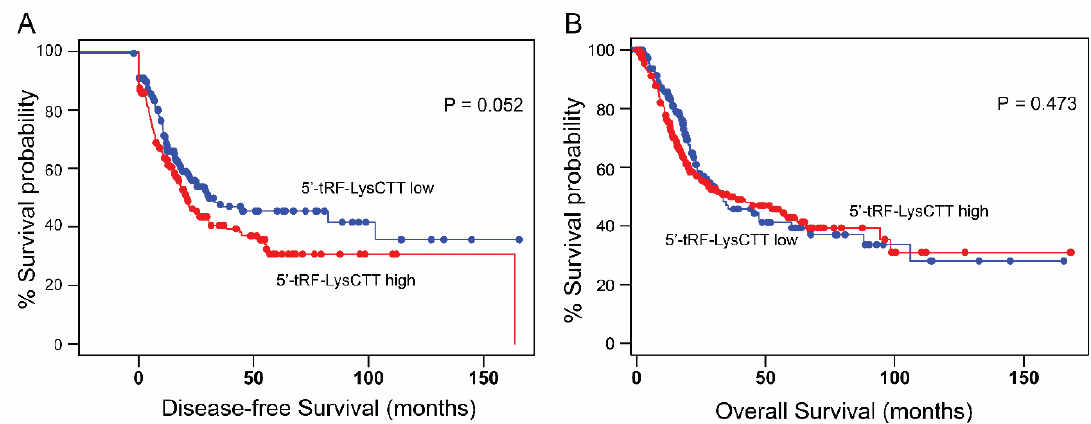
Figure 6. Survival analysis of TCGA-BLCA validation cohort. ( A , B ) Kaplan–Meier survival curves for the disease-free survival (DFS; ( A )) and overall survival (OS; ( B )) of the TCGA-BLCA validation cohort according to 5 ′ -tRF-LysCTT levels. The analysis performed via the OncotRF database. Red line: 5’-tRF-LysCTT high levels; blue line: 5’-tRF-LysCTT low levels.